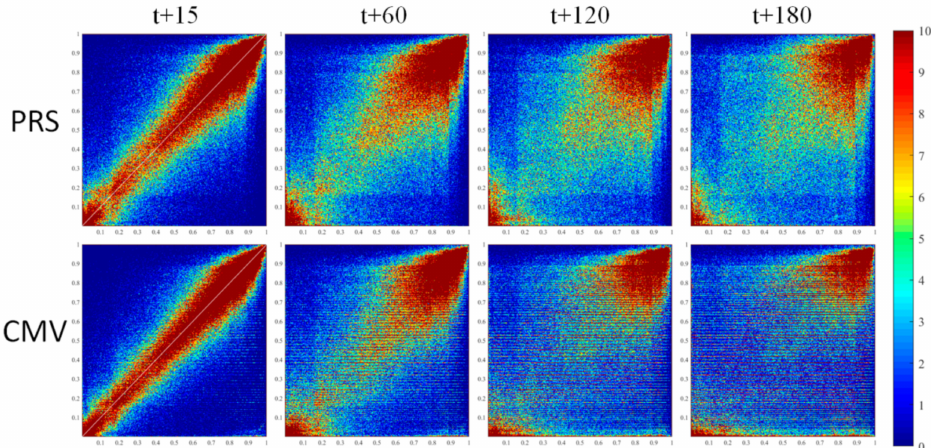
Figure 10. Density scatter plots of 30 April 2020 covering Europe and North Africa (i.e., 1.5 million pixels) for the PRS (upper line) and FRB forecasted COT (lower line) short-term forecast approaches, for the 15 min, 1, 2 and 3 h ahead time